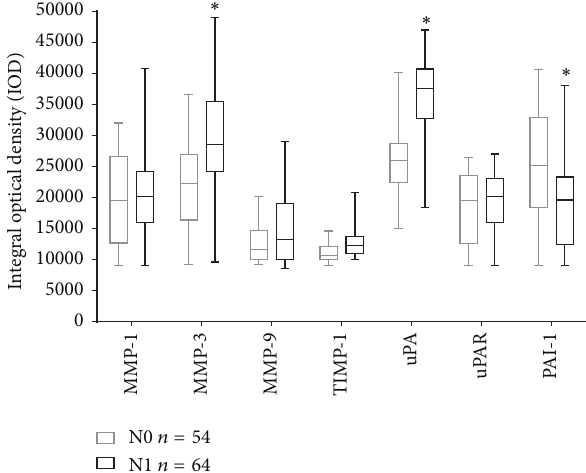
Figure 3: Semiquantitative expression of MMPs and the fibrinolytic system proteins in breast cancer samples. Expression of MMPs (MMP- 1, MMP-3, MMP-9, and TIMP-1) and proteins from the fibrinolytic system (uPA, uPAR, and PAI-1) in ductal breast cancer samples with metastasis (N1) and without metastasis (N0). Semiquantitation of the signal was performed using ImageJ software and statistic significance acquired applying the Mann–Whitney U test ∗ 𝑝 < 0.05